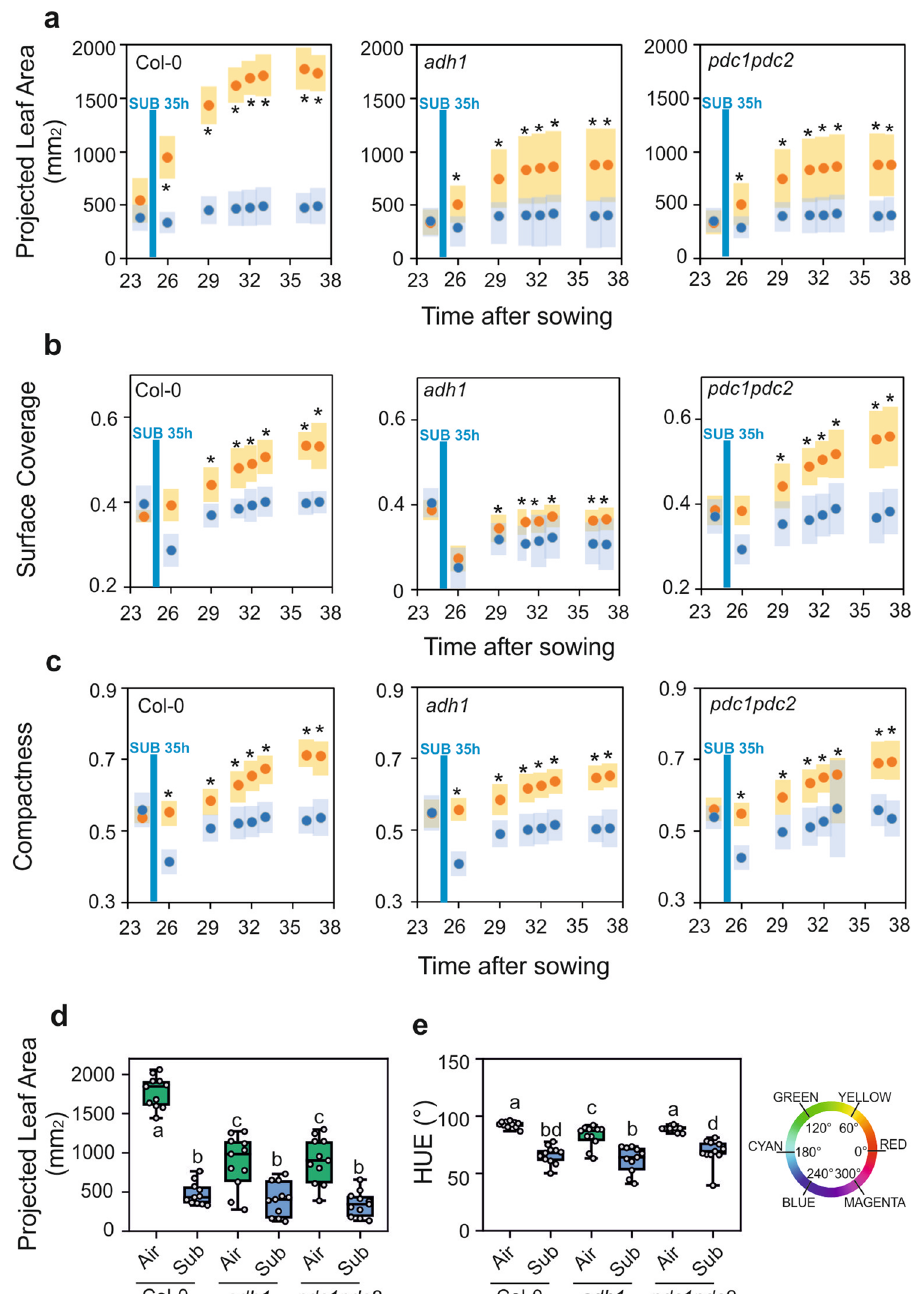
Figure 6. Plant size ( a ) and morphology traits ( b , c ) plotted against time in aerobic plants (orange symbols) compared to plants that were submerged for 35 h (blue symbols). Variance (± SD, n = 22) is shown as color- shaded areas (yellow: aerobic; light blue: submergence). Statistically significant differences are indicated by an asterisk (T-test, pairwise comparison at each time point, p < 0.01). ( d ) Plant size (projected leaf area) in aerobic plants (green box) compared to plants that were submerged (blue box). Data were taken at day 33. ( e ) Color (HUE value; HSI color space) in aerobic plants (green box) compared to plants that were submerged (blue box). The color wheel shows values for HUE ranging from 0 to 360°. Data were taken at day 33. Lines in the boxes indicate the median. The bottom and top of each box denote the first and third quartile, respectively. The dots represent the single data points and whiskers denote the min/max values. Different letters indicate statistically significant differences